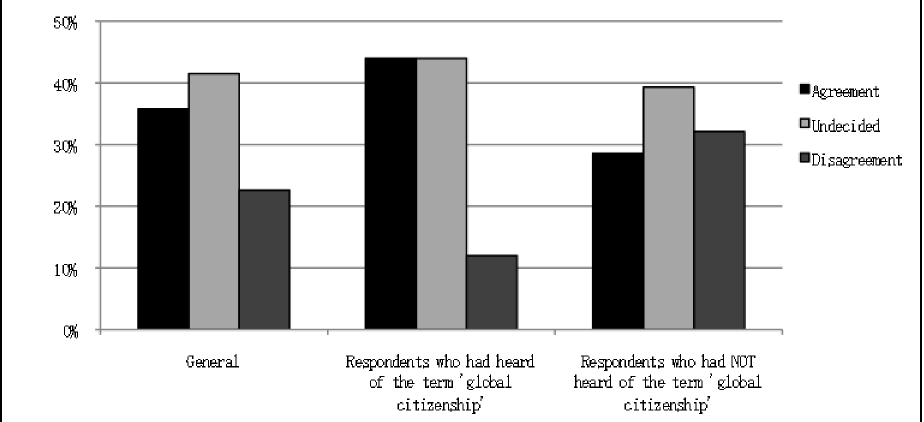
Figure 2:The attitude towards ‘I am a global